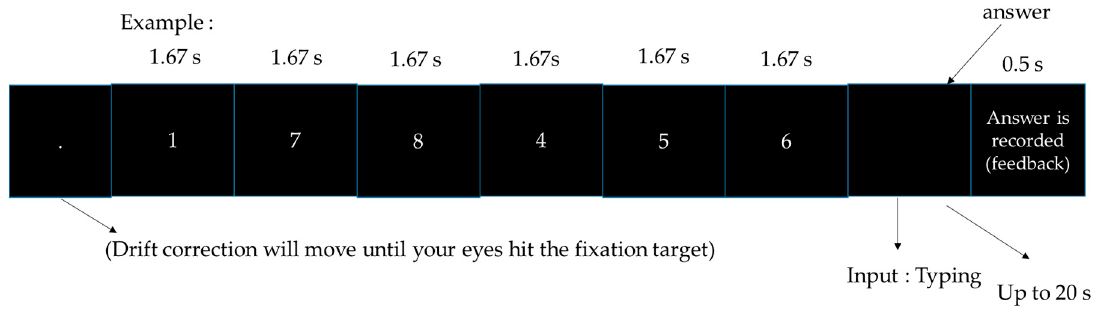
Figure 1. Backward digit span.